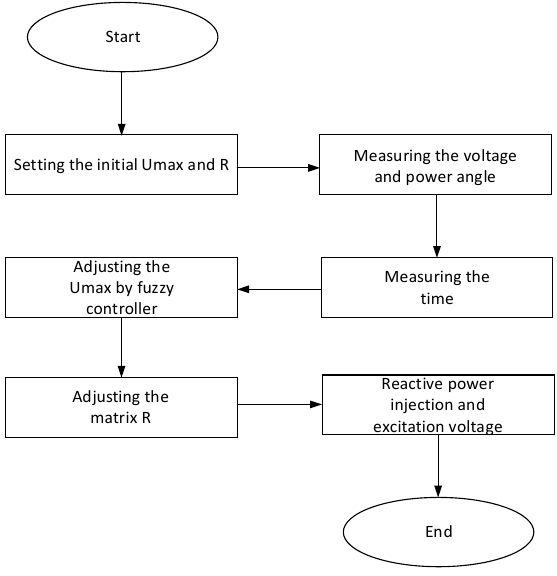
Figure 6. The control diagram of LOEC + AAL.